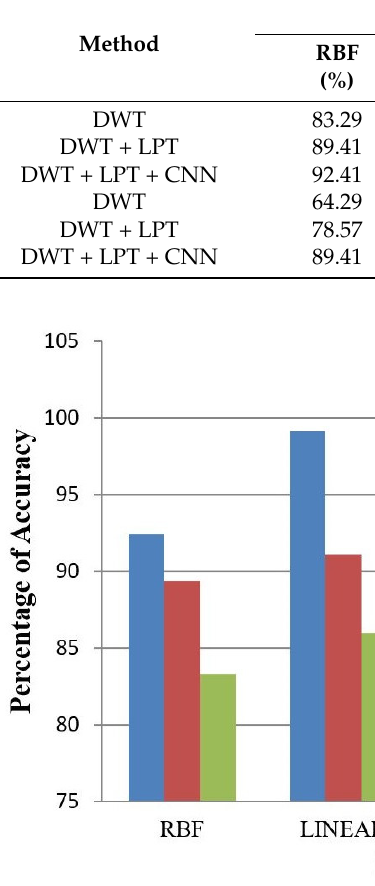
Table 4. Average accuracy for Distorted/Simulated Images.